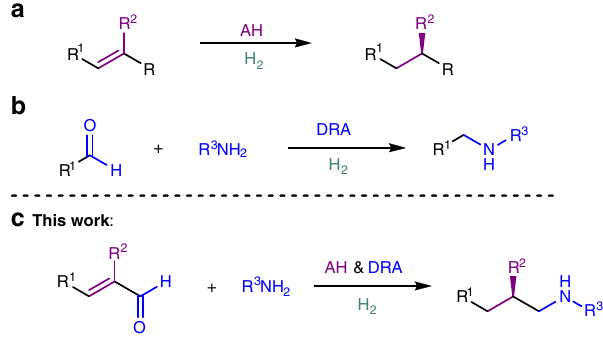
Fig. 1 The combination of asymmetric hydrogenation (AH) and direct reductive amination (DRA). a Asymmetric hydrogenation of ole fi ns. b Direct reductive amination of aldehydes. c This work: the combination of asymmetric hydrogenation and direct reductive